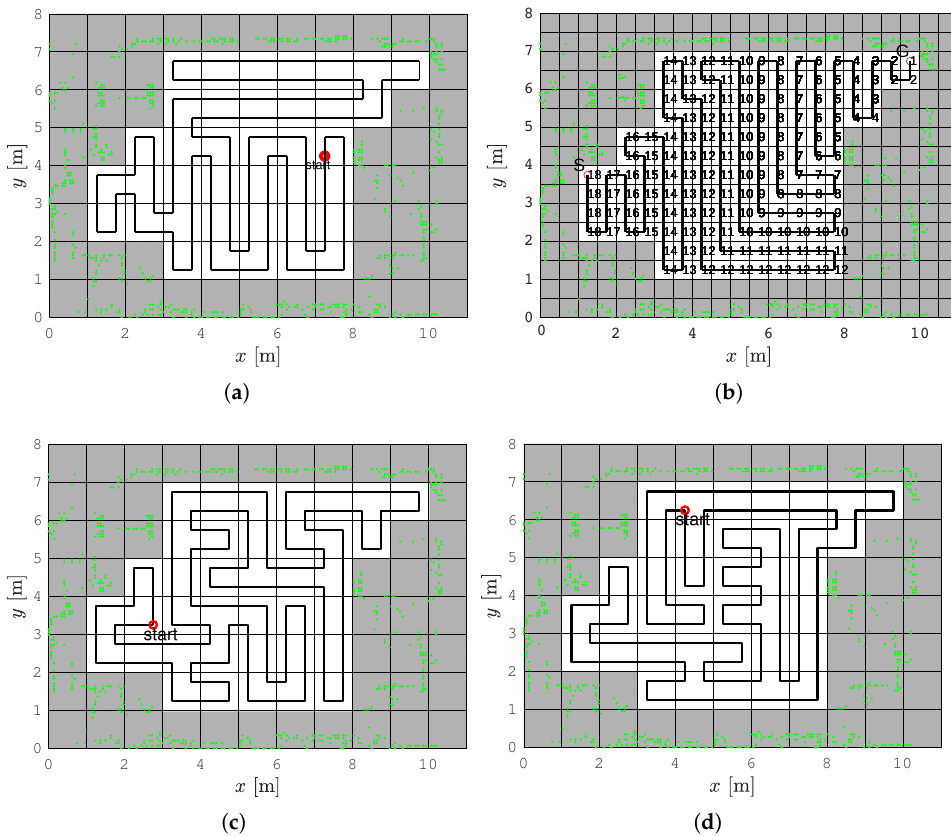
Figure 1. Solution examples of different methods for the TSP problem. ( a ) The RSTC algorithm, ( b ) The PT algorithm, ( c ) The ACO algorithm, ( d ) The HNN